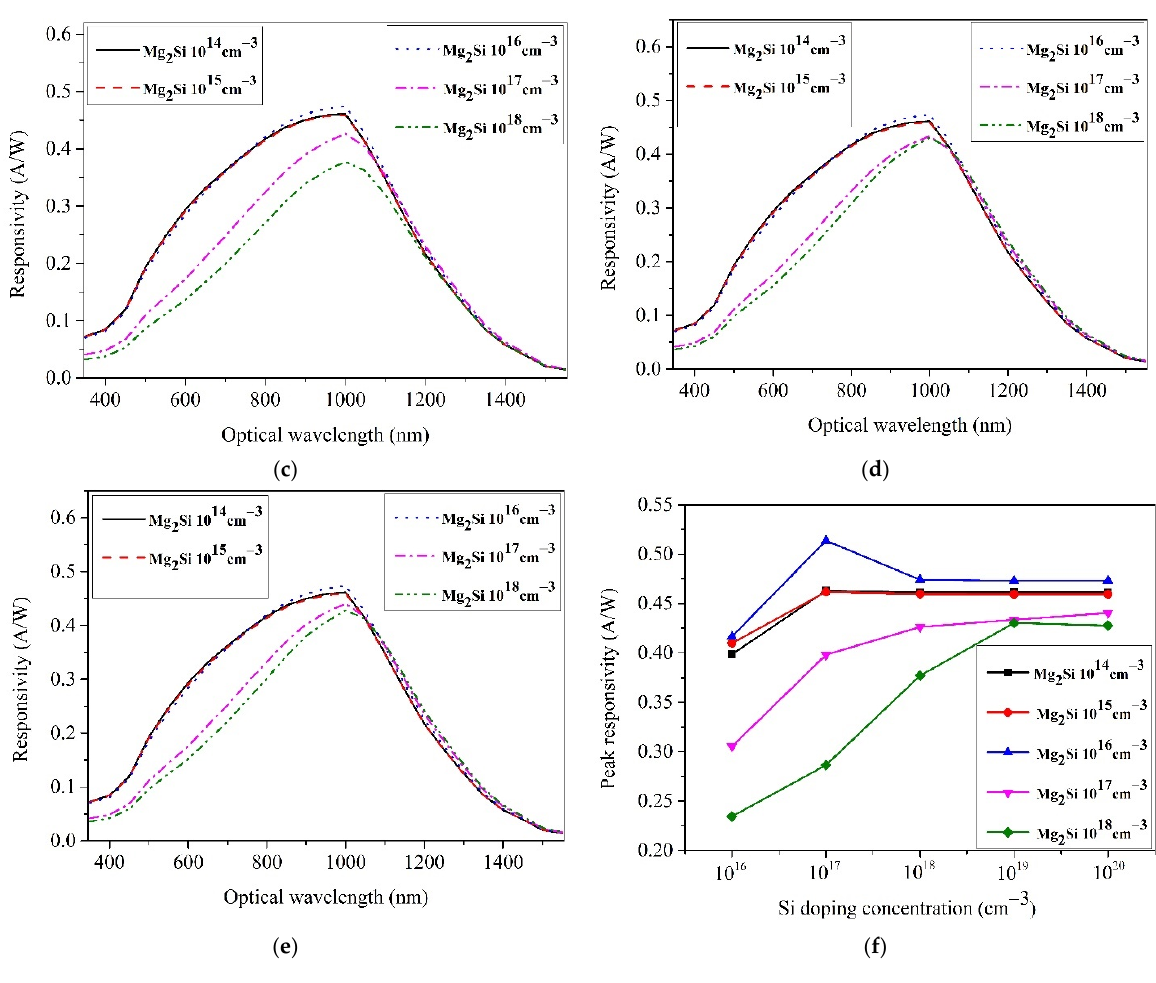
Figure 6. Responsivity curves of the heterojunction PDs with different doping concentrations. ( a ) Si–10 16 cm − 3 . ( b ) Si–10 17 cm − 3 . ( c ) Si–10 18 cm − 3 . ( d ) Si–10 19 cm − 3 . ( e ) Si–10 20 cm − 3 . ( f ) The effect of doping concentrations on responsivity.